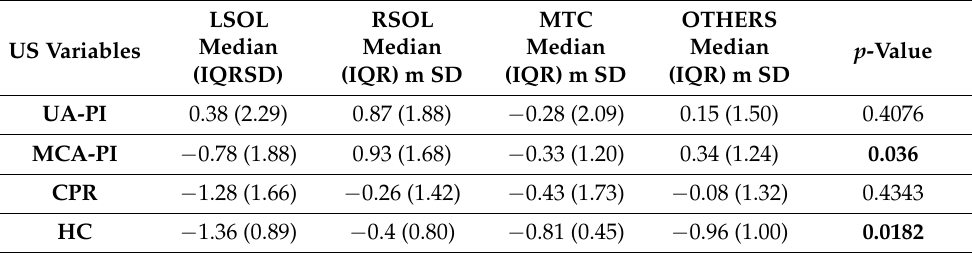
Table 2. One-way ANOVA Kruskal–Wallis Test using the z-scores of the variables analyzed, according to different types of CHD. CHD: congenital heart disease, HC: head circumference; UA-PI: pulsatility index of umbilical artery; MCA-PI: pulsatility index of middle cerebral artery; CPR: cerebroplacen- tal ratio; LSOL: left-sided obstructive lesions; RSOL: right-sided obstructive lesions; MTC: mixed type of CHD.